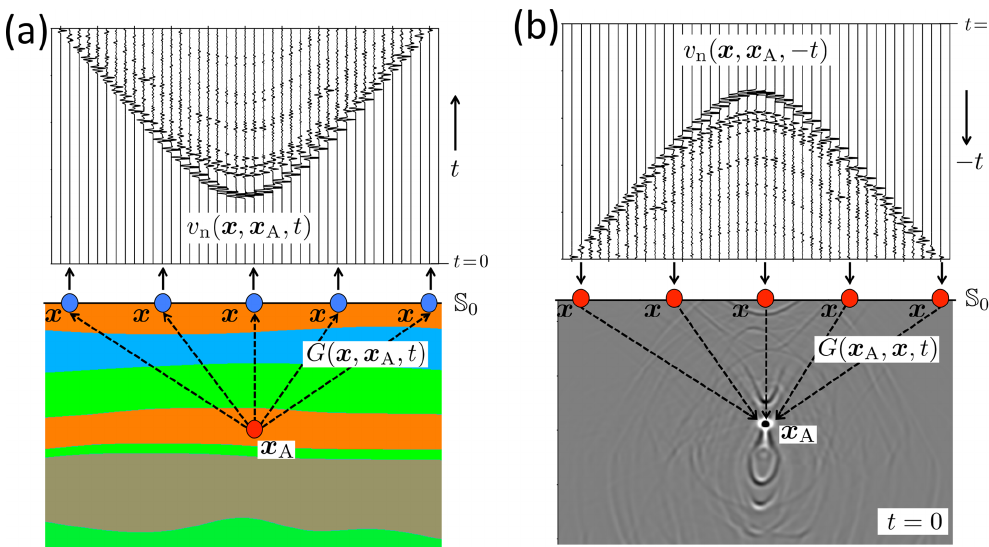
Figure 3. Time-reversal acoustics in a layered medium. (a) Forward propagation from x A to the finite open surface S 0 . (b) Emission of the time-reversed recordings from S 0 into the medium and a snapshot of the wave field at t = 0, with focus at x A